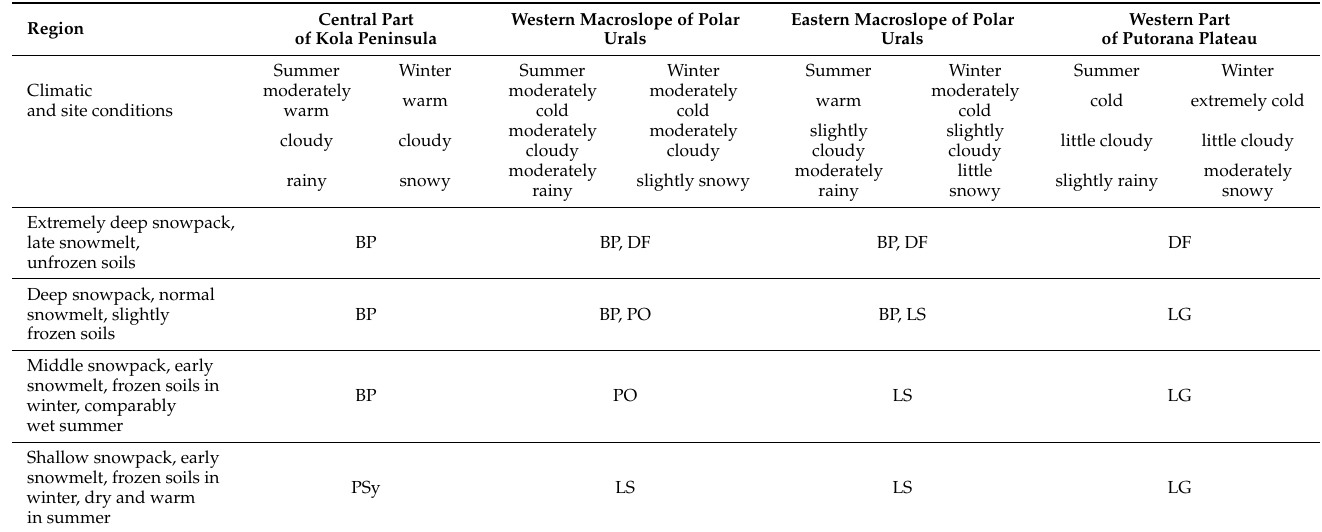
Table 7. Dominant species on the upper part of the treeline ecotones depending on site